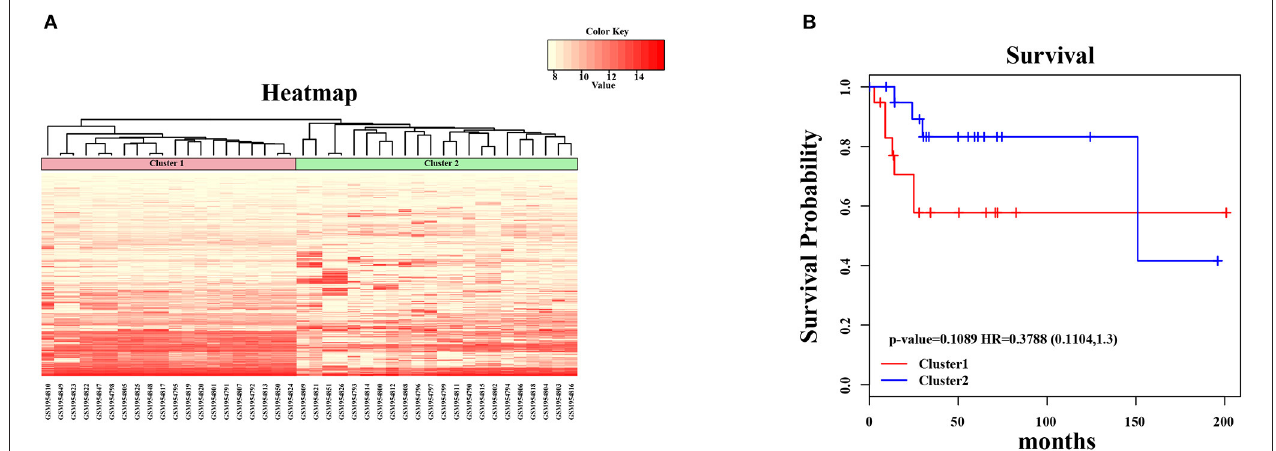
FIGURE 2 | Unsupervised hierarchical clustering analysis for 2-genes. (A) The expression heatmap of seed genes in all OSA tumor samples. The horizontal axis above represents the samples, using Euclidean distance; the samples were grouped into two clusters (cluster 1 and cluster 2). (B) The Kaplan–Meier survival curves of two different clusters. There was no significant difference between two clusters (log-rank test p > 0.05).